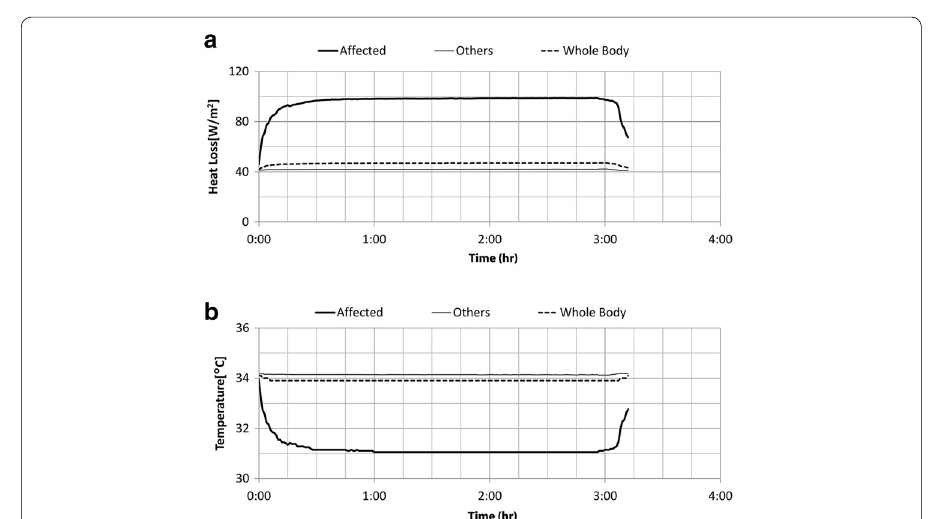
Fig. 5 Measurement result of FANS. a Heat loss, b